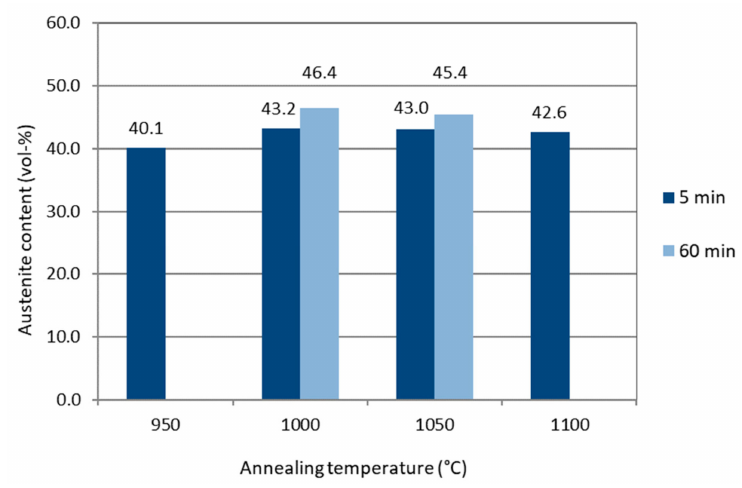
Figure 5. Austenite content (vol.%) for the various heat-treated specimens.